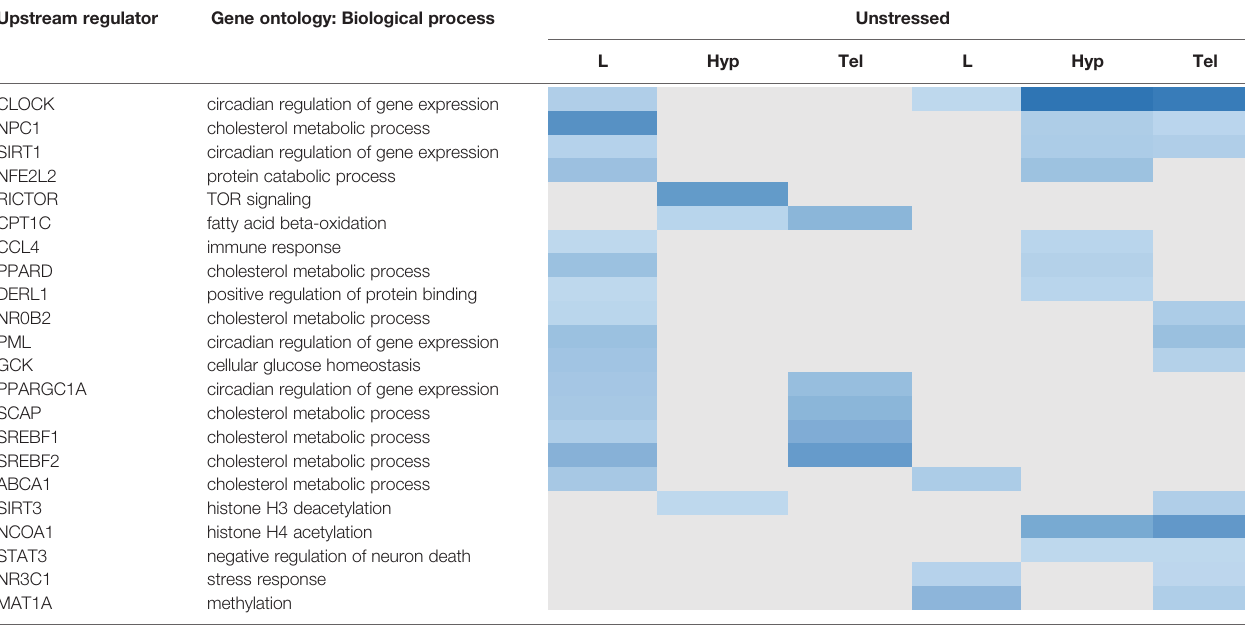
TABLE 1 | Upstream regulators associated with the genes altered by developmental exposure to fl uoxetine in zebra fi sh. Upstream regulator Gene ontology: Biological process